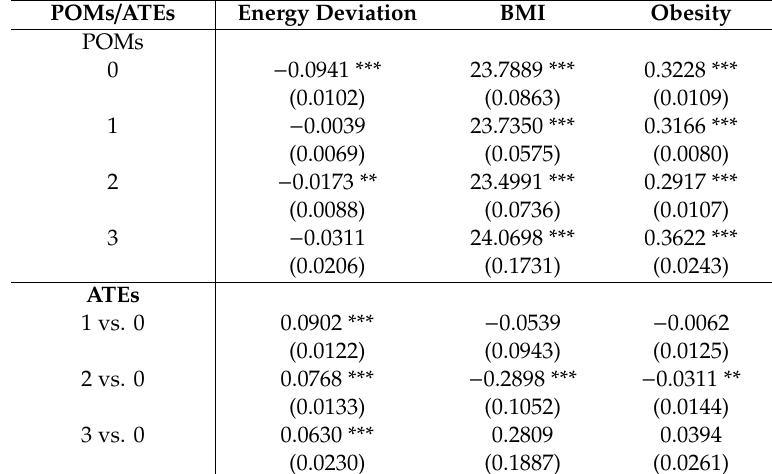
Table 8. The average treatment e ff ects on calorie intake, BMI and obesity.